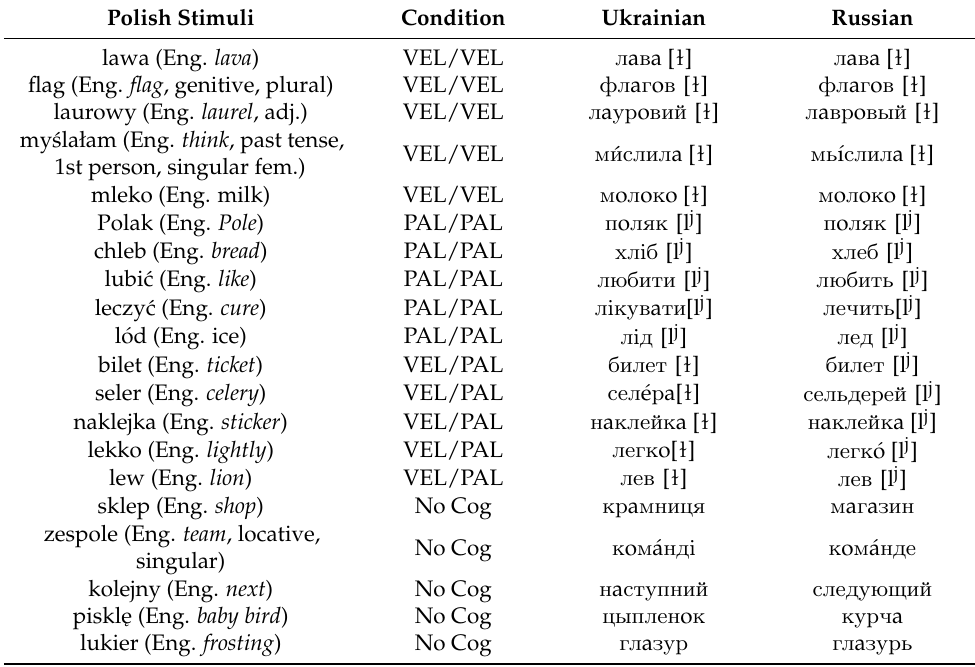
Table A1. Stimuli divided into conditions and their cognates in Ukrainian and